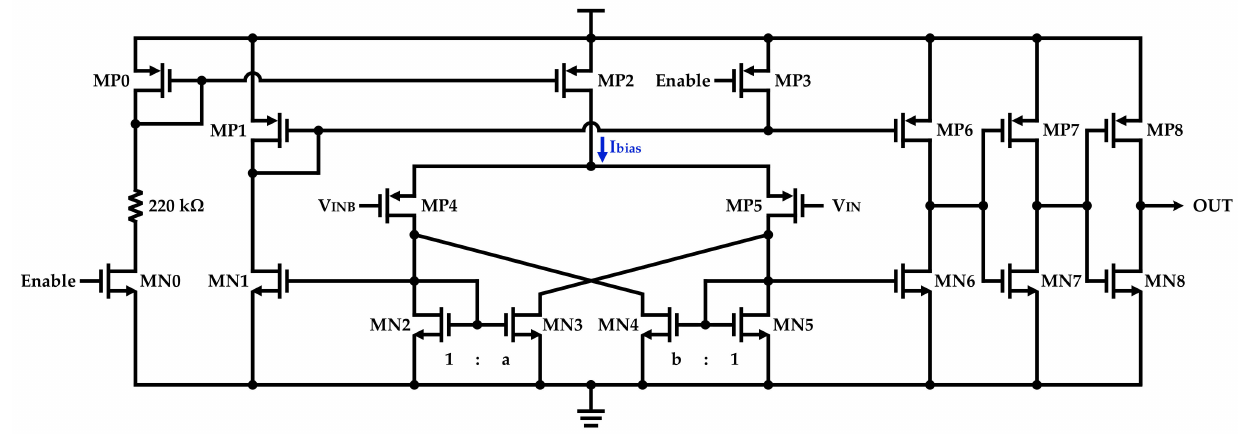
Figure 3. Structure of the implemented hysteresis comparator.